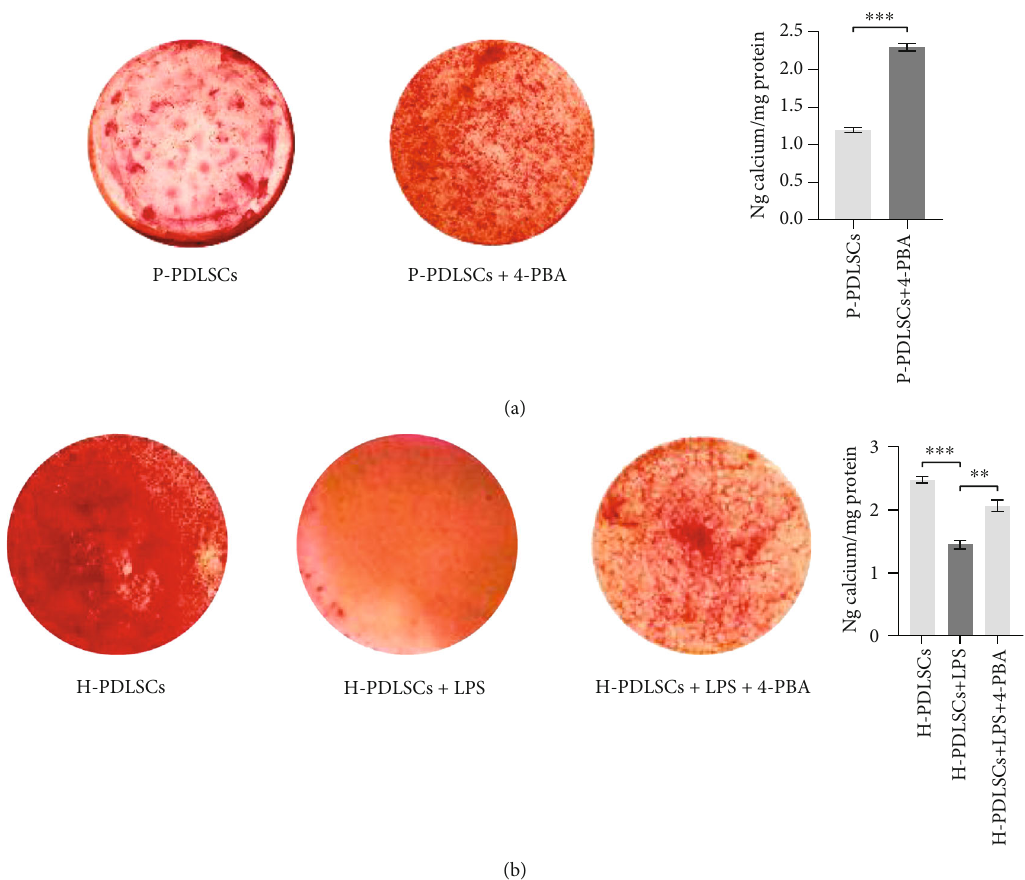
Figure 4: Alizarin red staining. (a) P-PDLSCs were treated without or with 5 mM 4-PBA, and (b) H-PDLSCs treated in the absence or presence of 10 mg/l LPS or LPS in association with 5 mM 4-PBA for 28 days. The data represent mean ± standarddeviations ( n = 3 ). ∗ P < 0 : 05 , ∗∗ P < 0 : 01 , ∗∗∗ P < 0 : 001